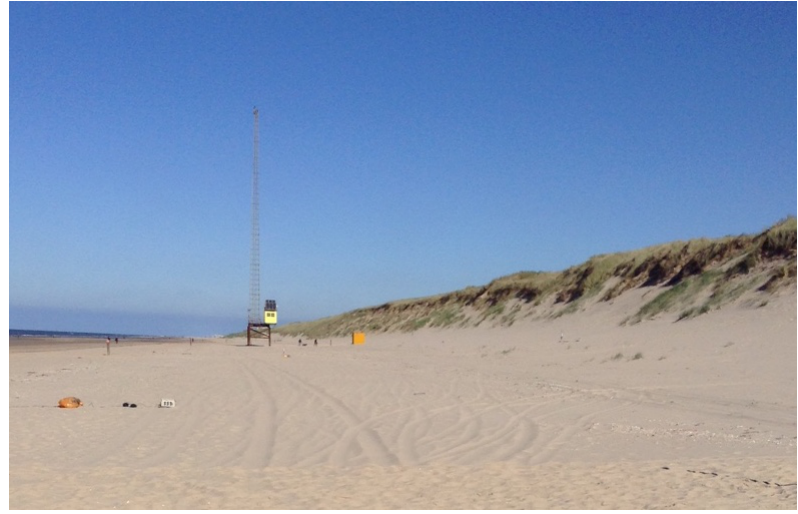
Figure 4. Argus station-Coast3D tower-at Egmond